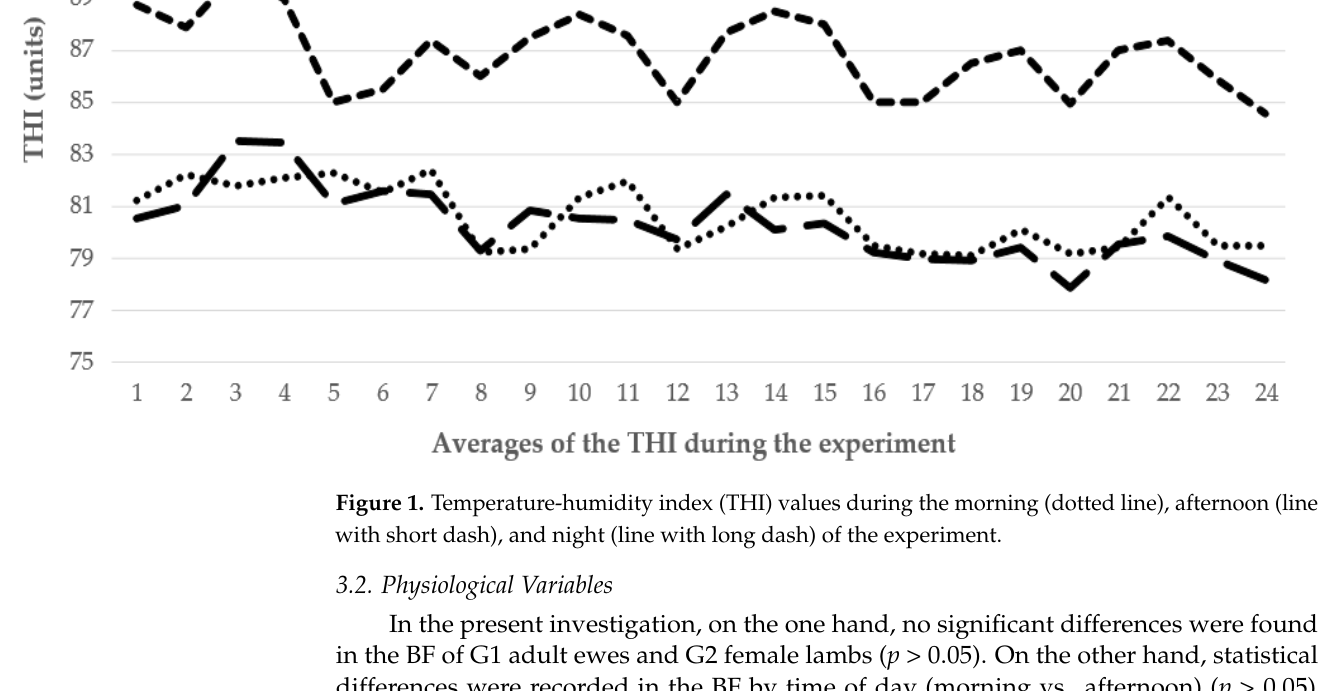
(line with short dash), and night (line with long dash) of the experiment. with short dash), and night (line with long dash) of the experiment.